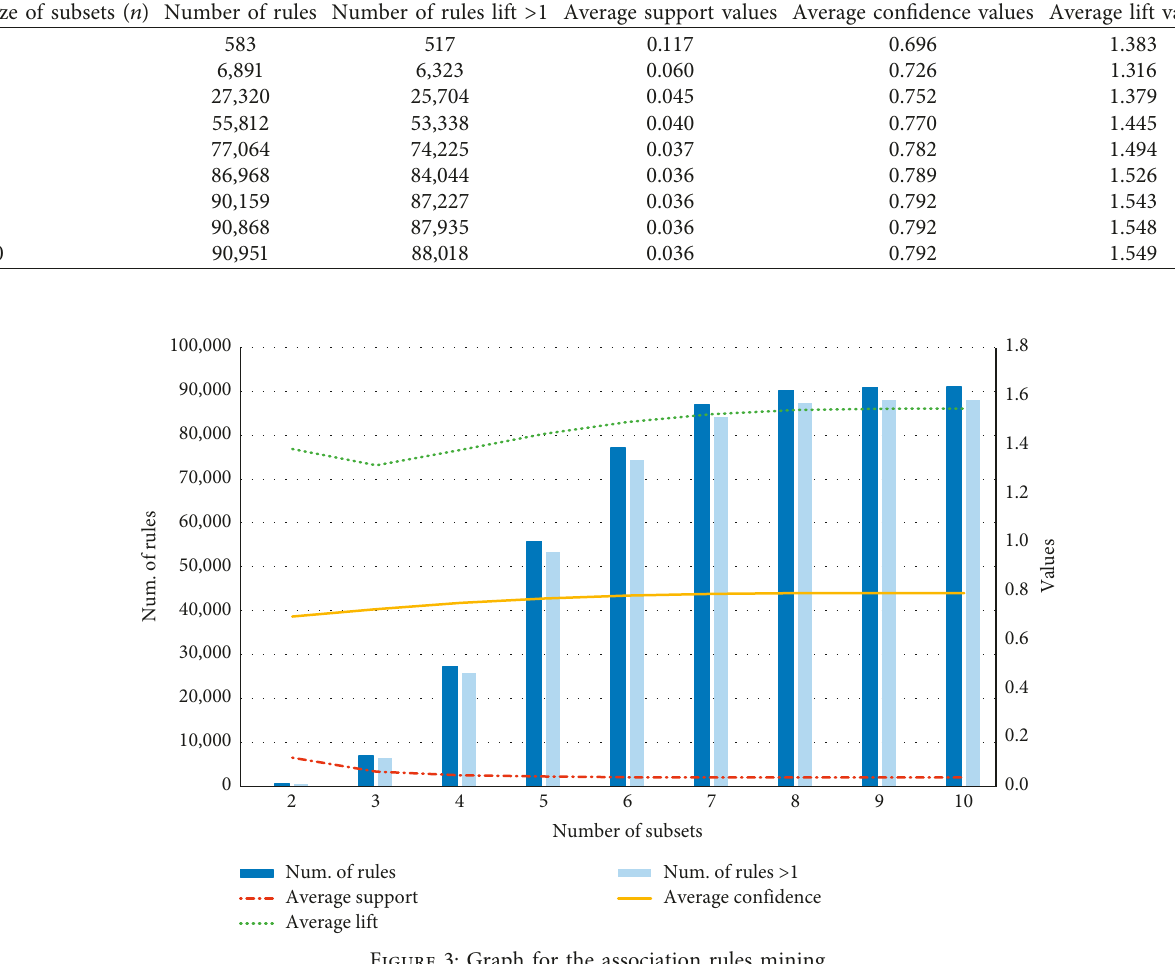
Table 3: Average support, confidence, and lift values by subset sizes.